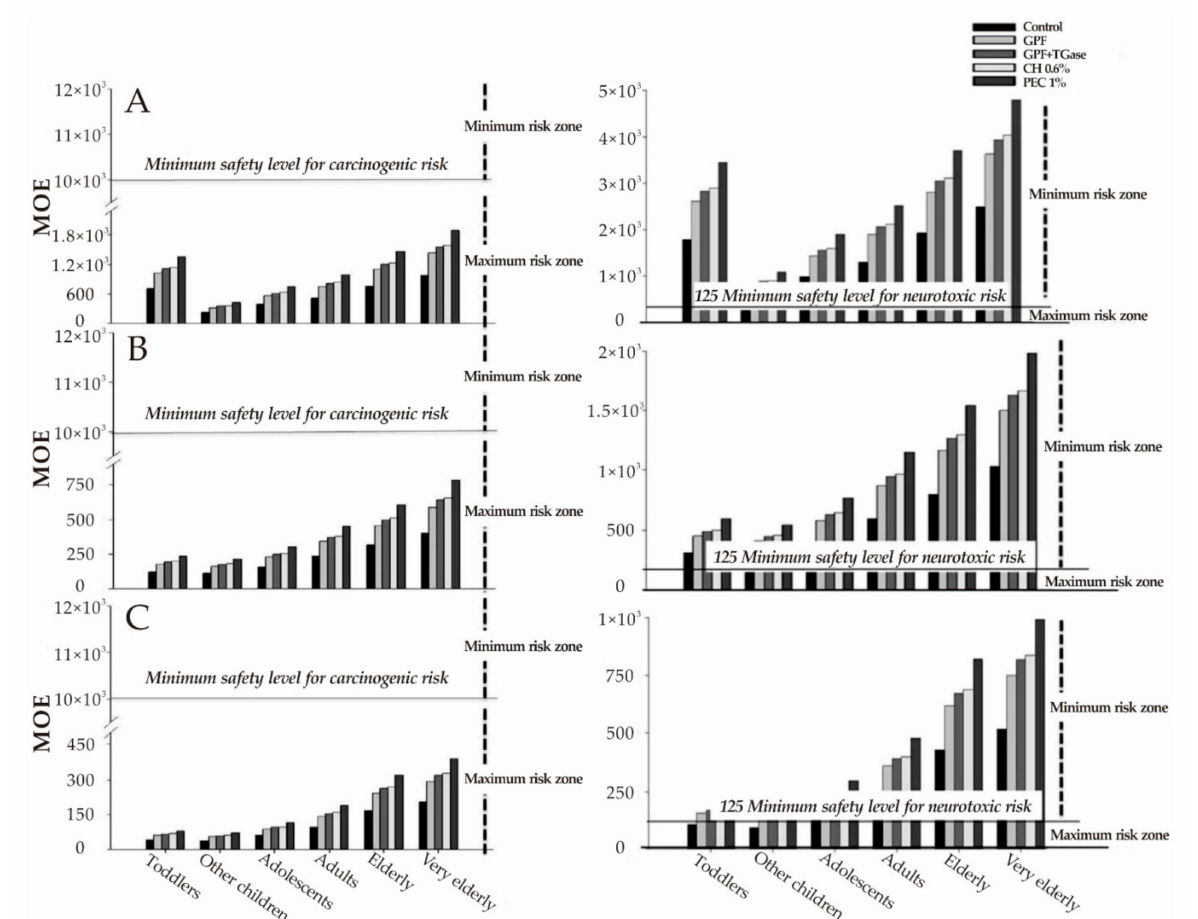
Figure 7. MOE values for carcinogenicity ( left panel ) and neurotoxic ( right panel ) of acrylamide through the consumption of French fries that were both uncoated and coated with hydrocolloid coating solutions. Samples were coated with different polysaccharides-based coatings made of PEC, pectin; and CH, chitosan. “Uncoated” represents the control sample dipped in distilled water, across different consumer age groups: ( A ) minimum, ( B ) median, and ( C ) maximum of consumption levels estimated from the 2015 EFSA report. (Adapted with permission from Al-Asmar [199]; published by MDPI,